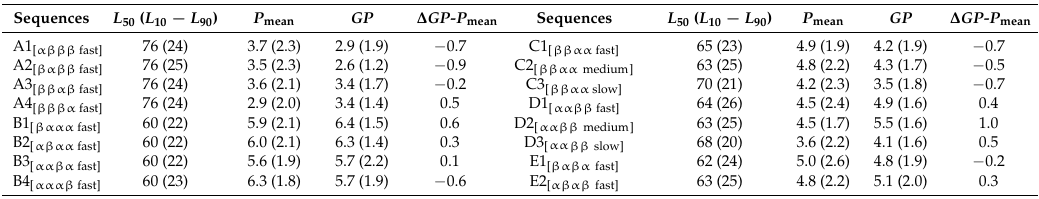
Table 2. Pleasantness averaged both over participants and over time ( P mean ), the global sound pleasantness ( GP ) averaged over participants, and the difference between both ( ∆ GP-P mean ), for each of the 16 sequences.